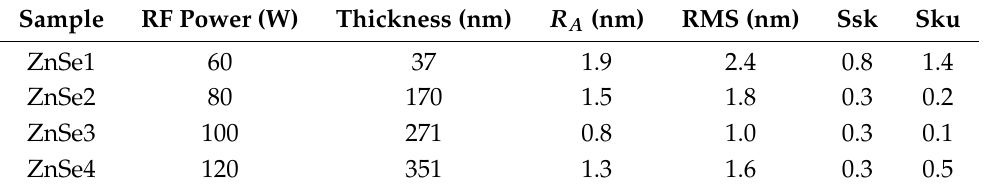
Table 2. Morphological parameters evaluated by AFM in tapping mode for the ZnSe thin films RF-sputtered at: 60 W, 80 W, 100 W, and 120 W. Corresponding thickness values of the films, as measured by SEM, are indicated as